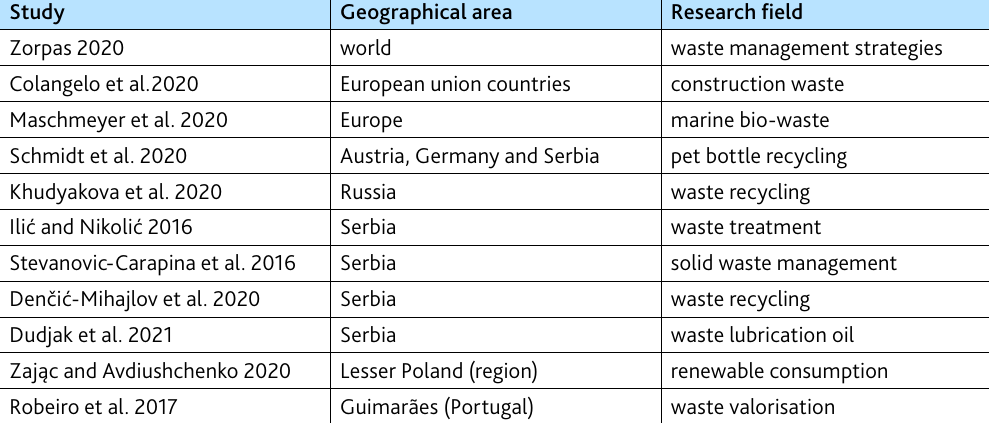
Table 2. Studies of waste management identified in this